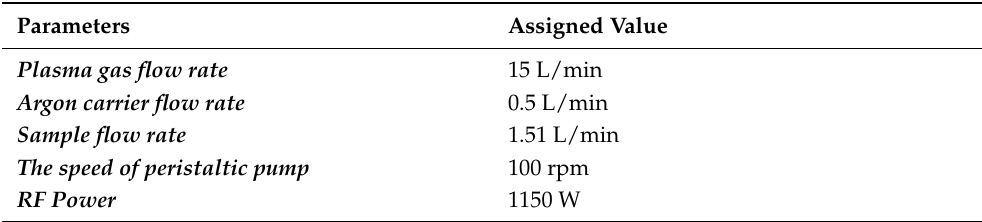
Table 1. ICP-OES device parameters for determination of trace and toxic elements.